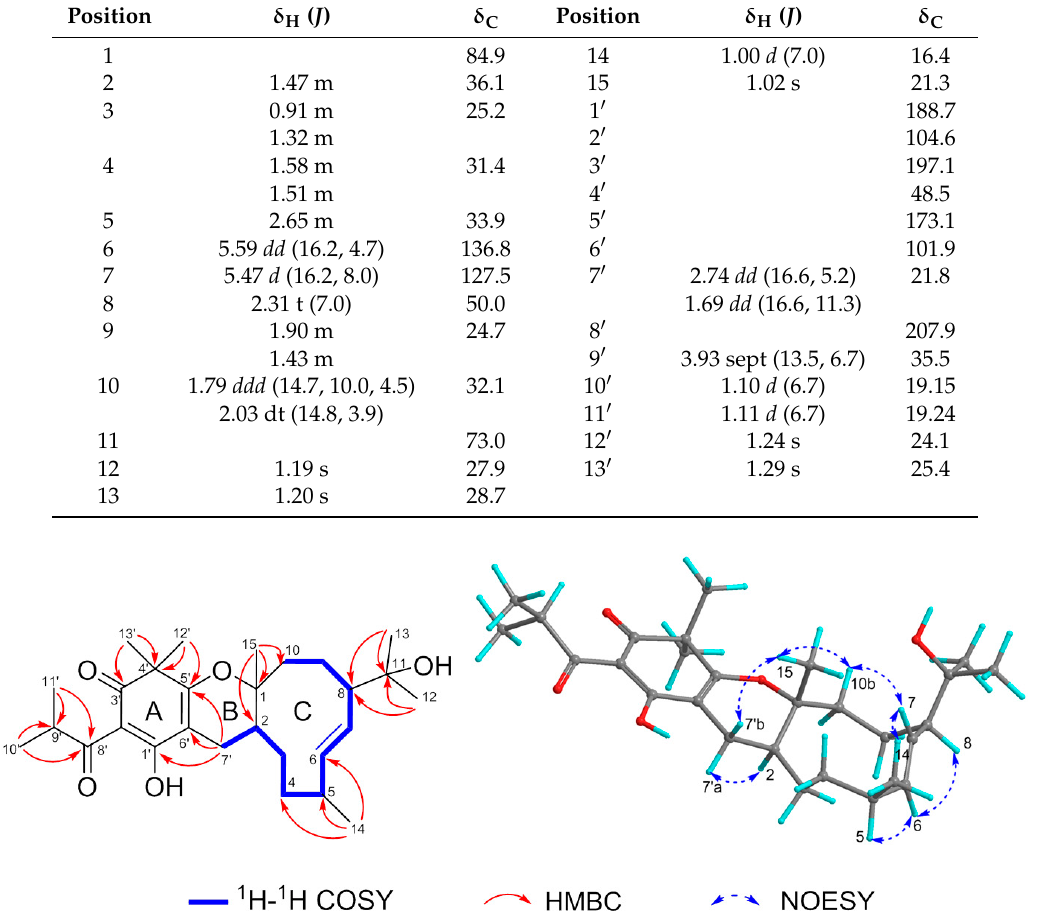
Table 1. 1 H-NMR (600 MHz) and 13 C-NMR (150 MHz) spectral data of compound 1 in CDCl 3 ( δ in ppm, J in Hz).